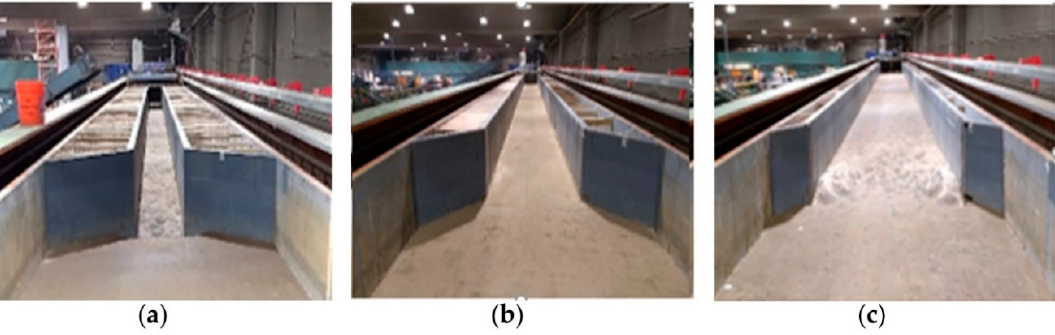
Figure 1. Views of the contracted flume for three different contraction ratios: ( a ) B 2 /B 1 = 0.25; ( b ) B 2 /B 1 = 0.50; ( c ) B 2 /B 1 = 0.75.